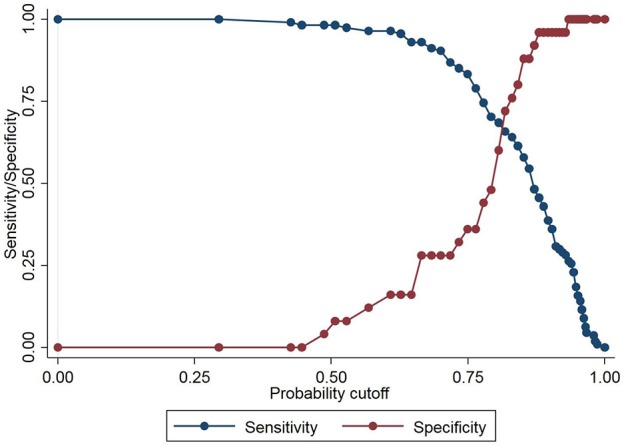
Graph illustrating the best cut-off point for the CT derived pulmonary artery/ascending aorta ratio to detect PH. The best cutoff derived from the Youden index was 0.80.